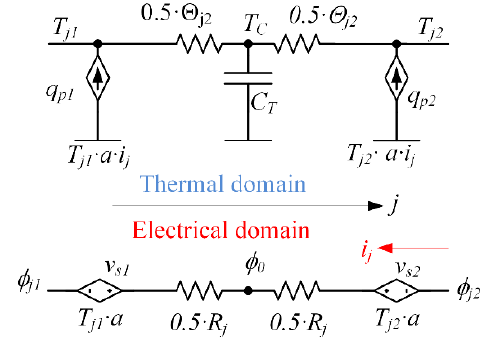
Figure 4. Illustration of thermoelectric e ff ects and interaction between thermal and electric domains in an elemental volume from Figure 3. The global axis j is used instead of x -, y - or z -axes. R j is the ohmic resistance of the elemental volume on j -axis and Θ j is its thermal resistance on j-axis. When a load is connected to electrical terminals, an electric current i j flows through the volume.